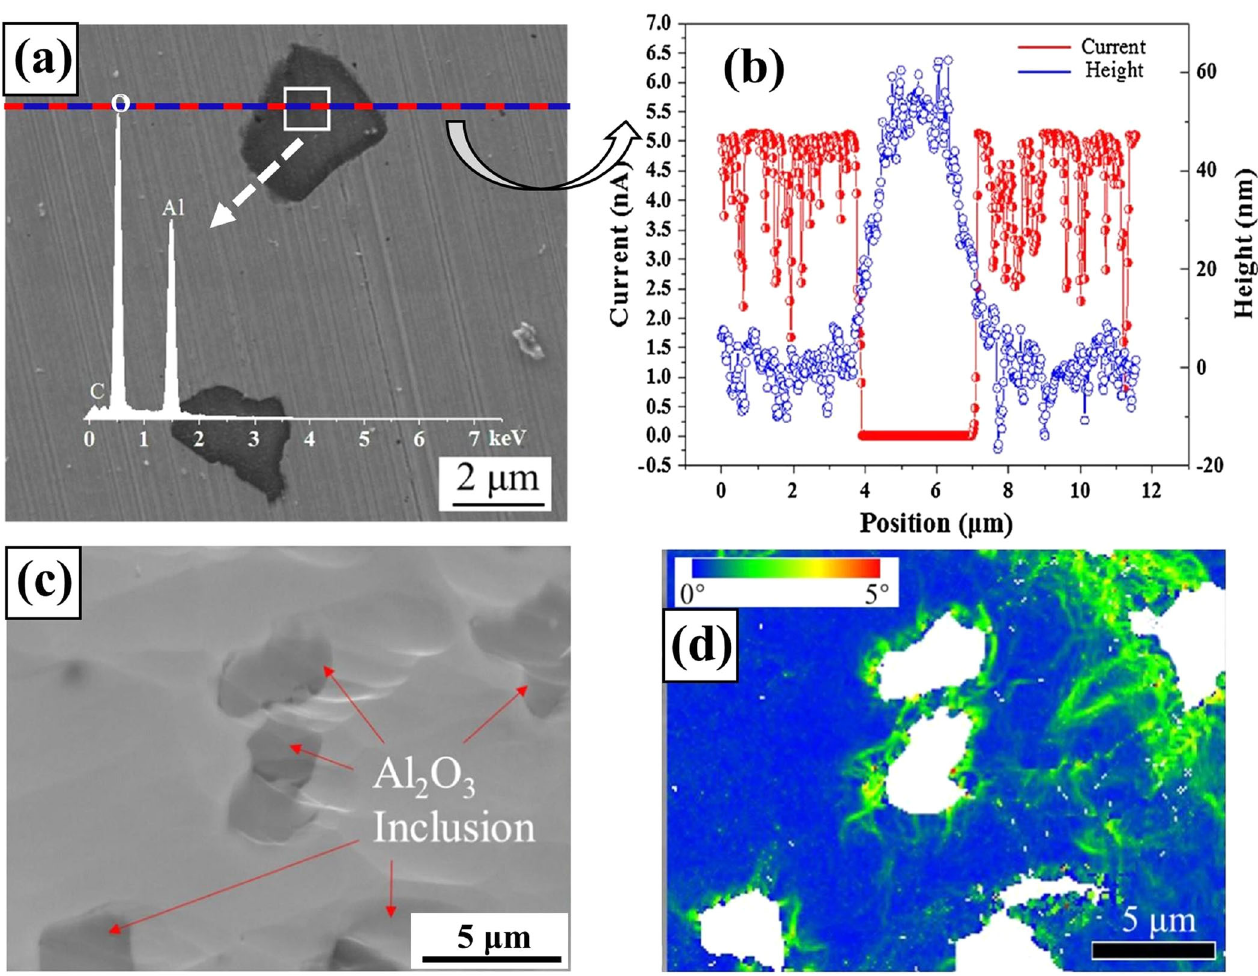
Fig. 10 Morphology and properties of Al 2 O 3 inclusions in Al-killed steel. a SEM images of Al 2 O 3 inclusions in Al-killed steel. b Morphology and conductive analysis results of line pro fi le in the same region shown in a , gained with a potential of + 6.0 V applied to the tip. EBSD images of a region containing Al 2 O 3 inclusions: c SEM images and d the corresponding KAM map of the same region shown in c 24